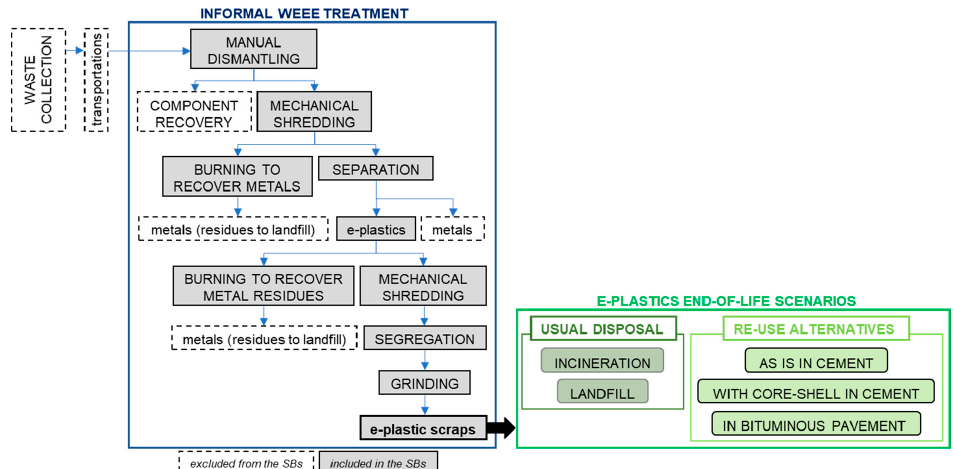
Figure 2. System boundaries for the informal treatment and the end-of-life scenarios for e-plastics.